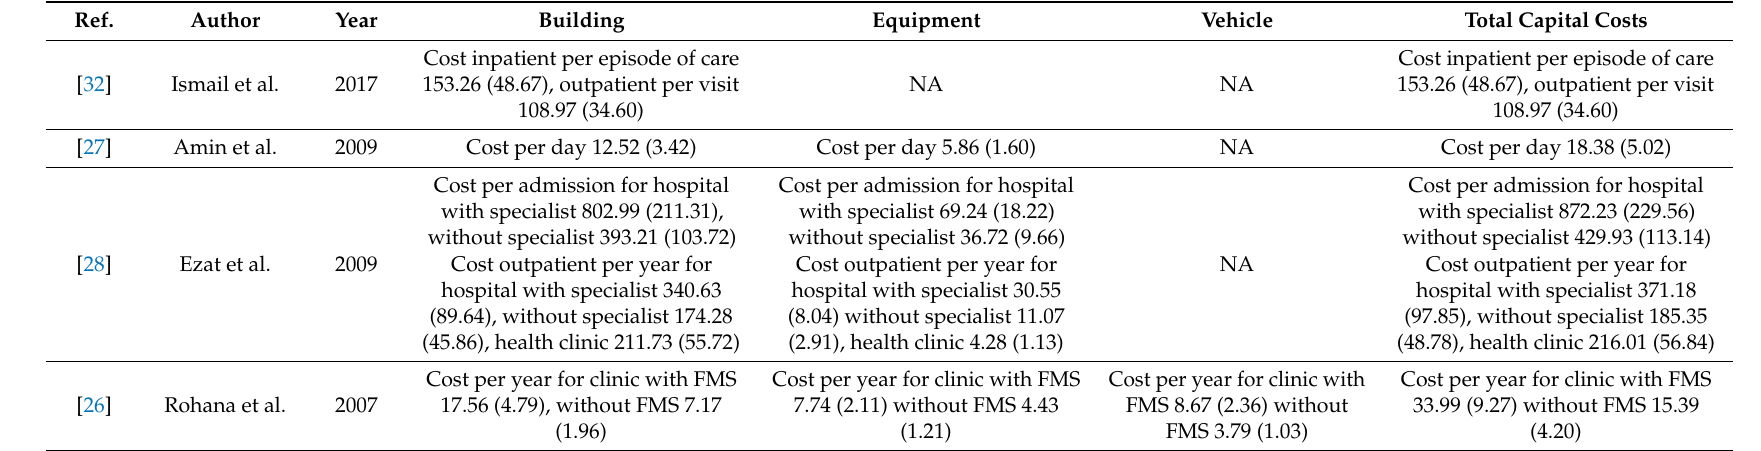
Table 4. Costing items, estimates per person and total costs in studies reporting capital costs of diabetes individuals.